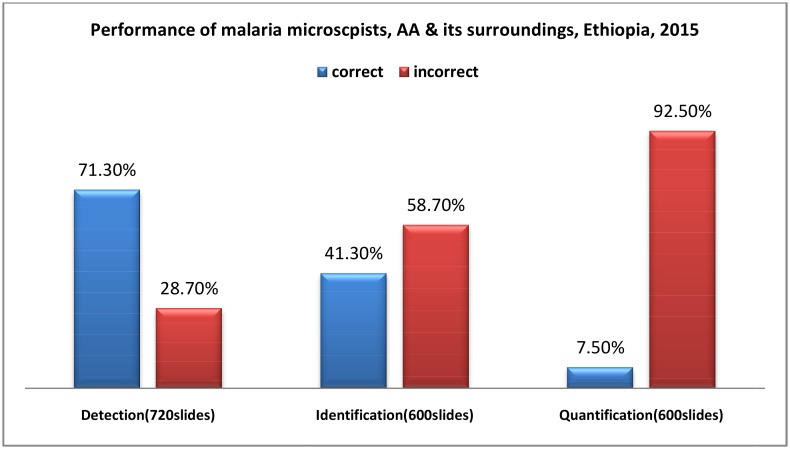
Performance of malaria micrscopists, Addis Ababa, and its surroundings, Ethiopia 2015.